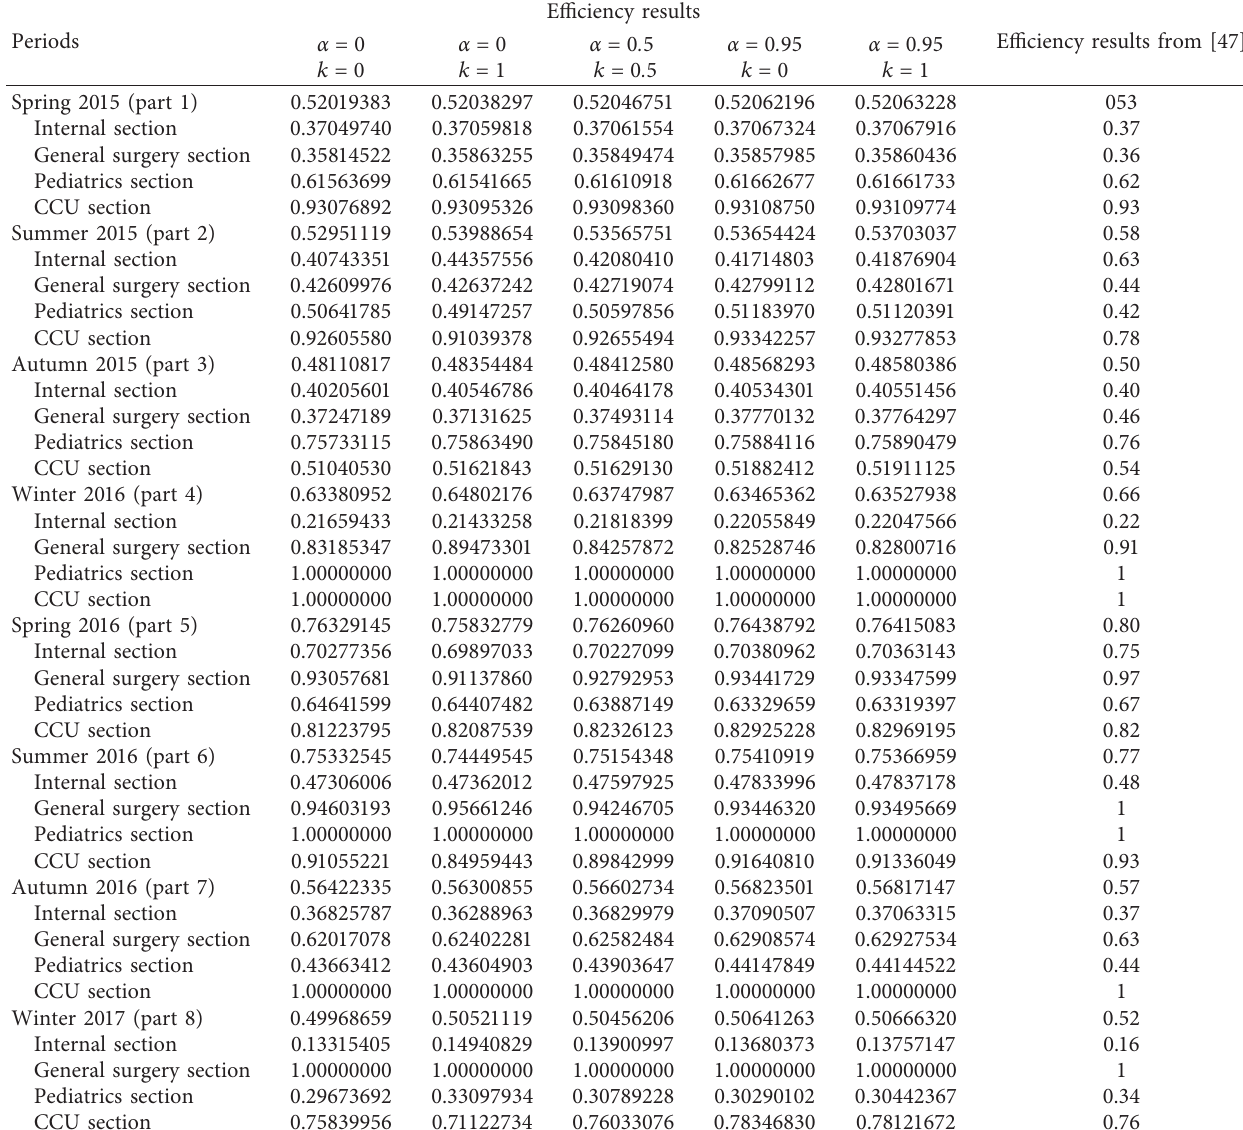
Table 10: Part and section efficiencies of Imam Khomeini